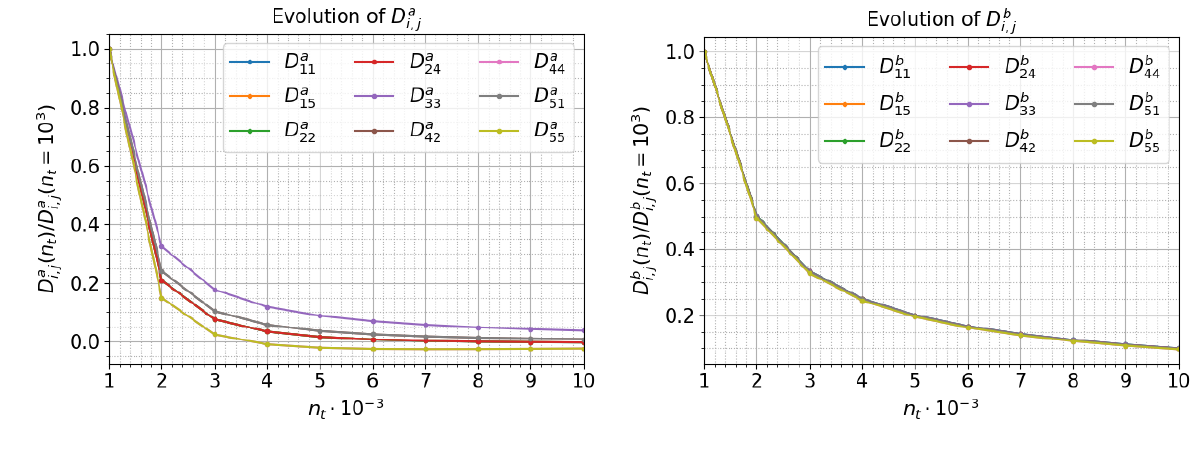
Figure 14. Evolution of D a and D b when increasing n t